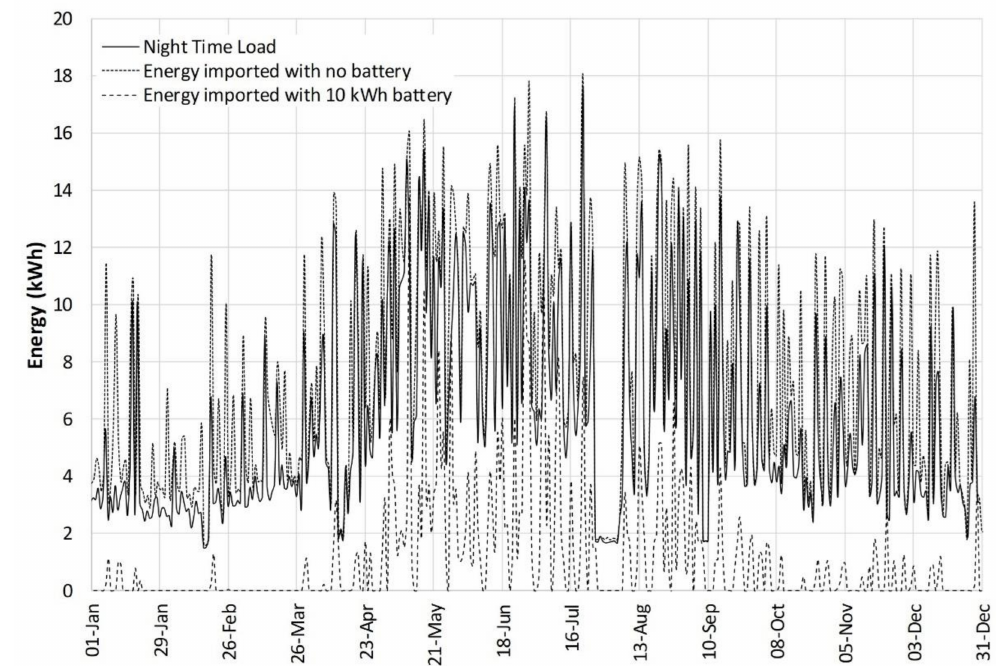
Figure 12. Night load and energy imported with and without a 10 kWh